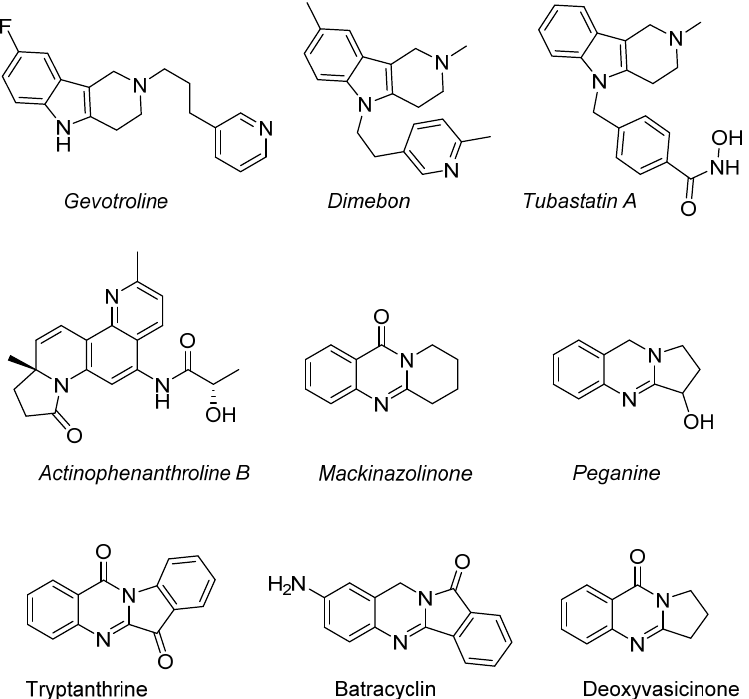
Figure 1. Structure of several tetrahydro- γ -carbolines, actinophenanthrolines and quinazoline alka-